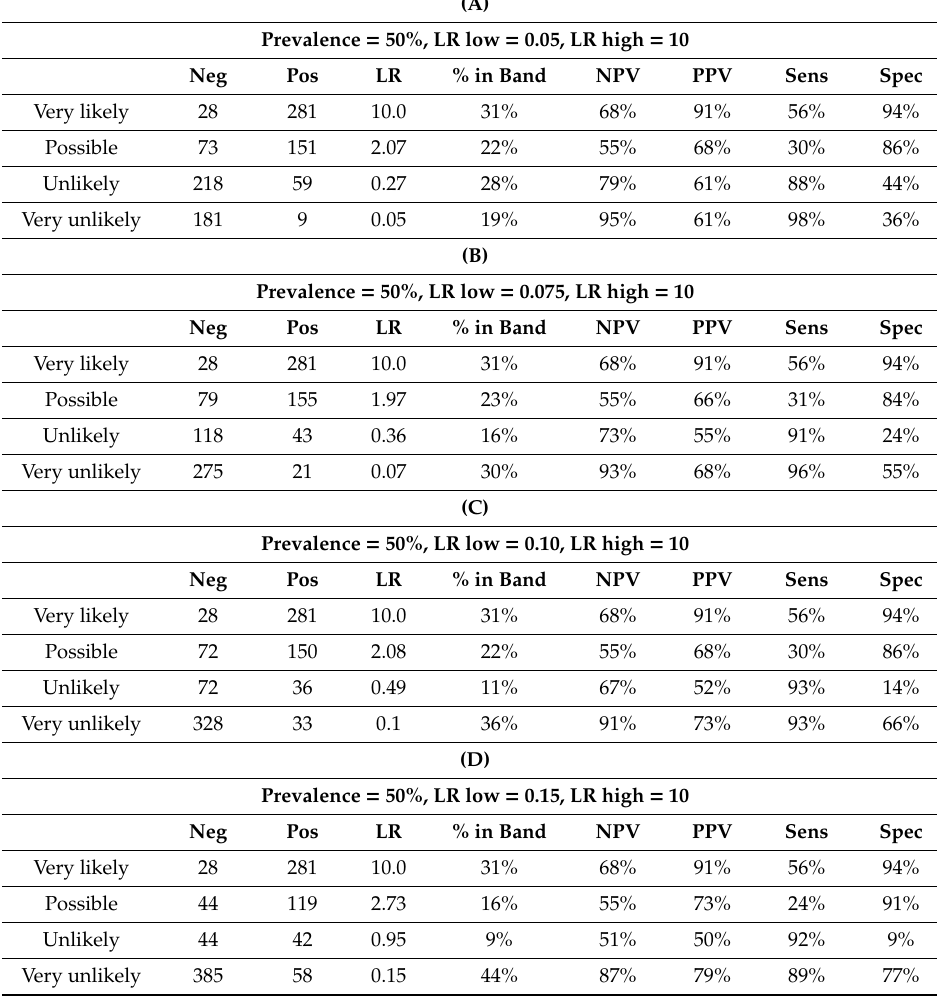
Table 3. Calculations for InSep results at a fixed prevalence of 50% but varying likelihood ratios for the low (very unlikely = rule-out) interpretation band ranging from 0.05 ( A ), 0.075 ( B ) to 0.1 ( C ) and 0.15 ( D ) based on modelled